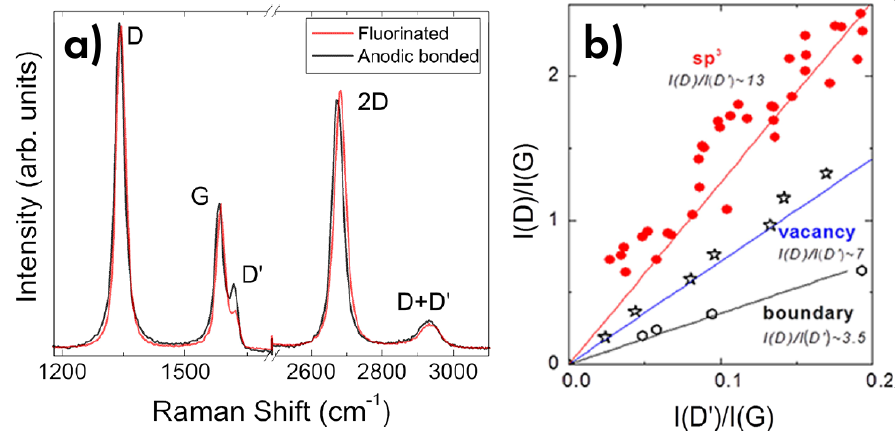
Figure 23. ( a ) Raman spectra of defective graphene produced by fluorination (saturated defects) and anodic bonding (unsaturated defects). ( b ) Linear dependence between the I D /I D’ ratio for graphene featuring different types of defects. Adapted with permission from Ref. [92]. Copyright (2012) American Chemical